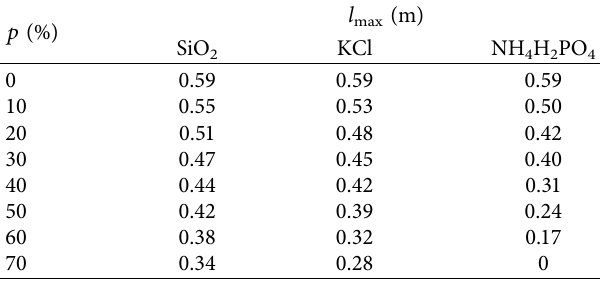
Table 4: Inhibition of an explosion suppressant on the explosion fame of nonstick coal dust.